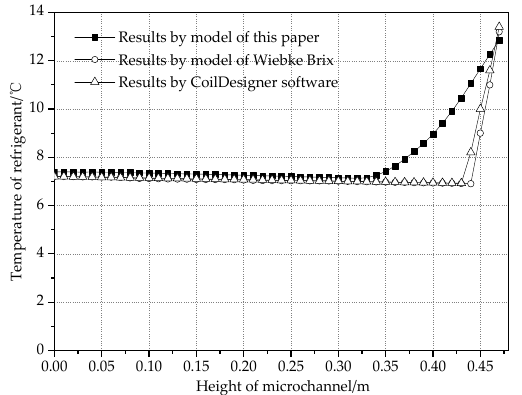
Figure 7. Comparison of the refrigerant temperatures along the channel.